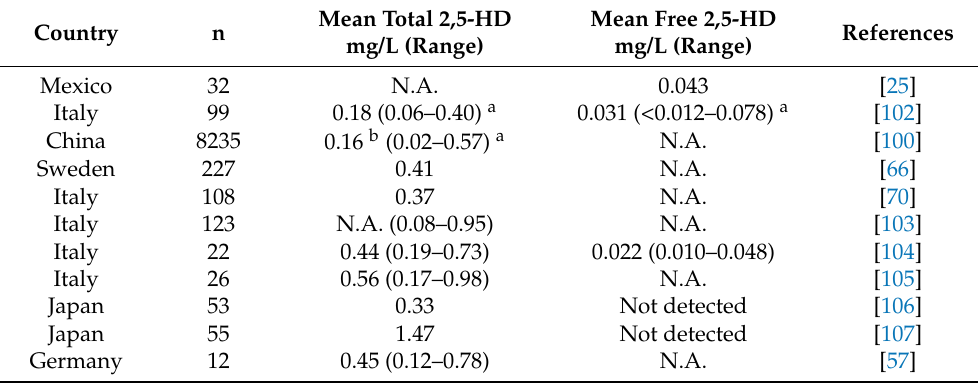
Table 3. Concentrations of 2,5-HD in urine of non-occupationally exposed